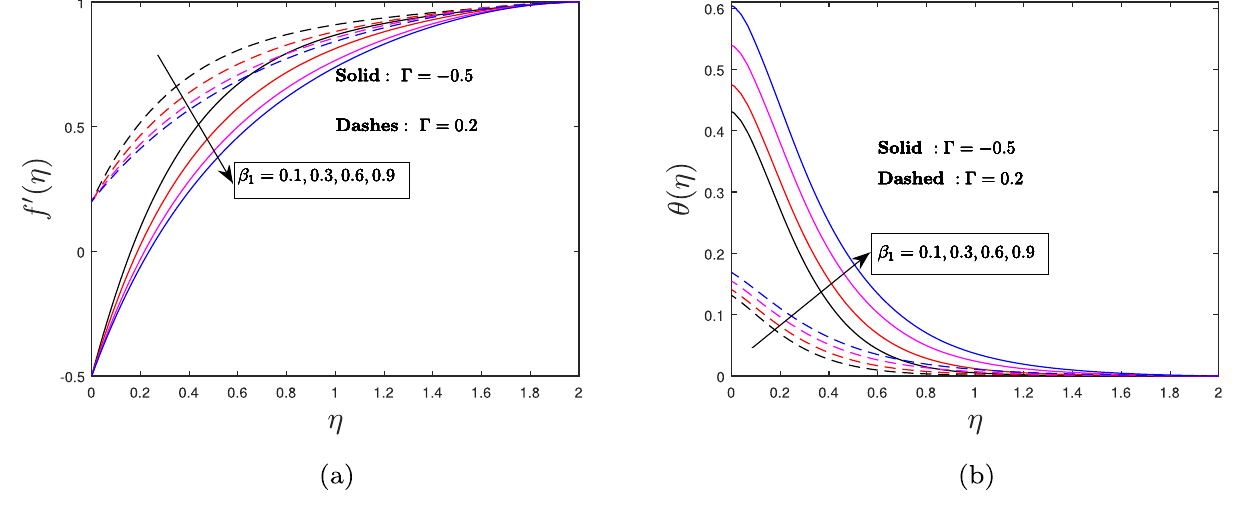
Figure 9: ( a ) Velocity and ( b ) thermal fi elds against di ff erent β